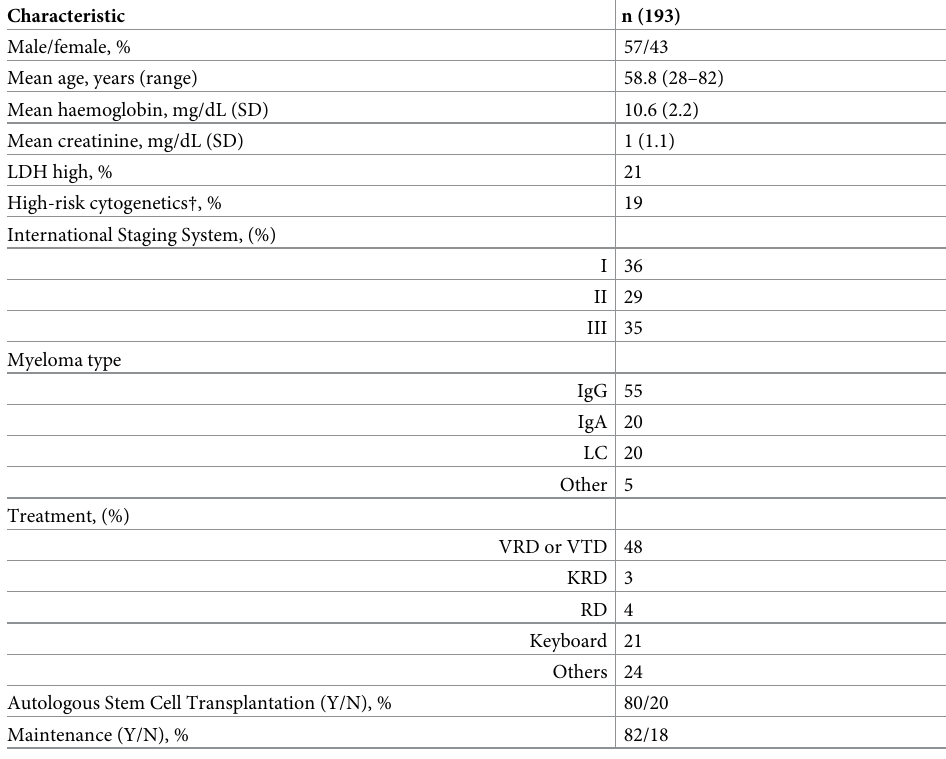
Table 1. Main clinical characteristics of the included patients.